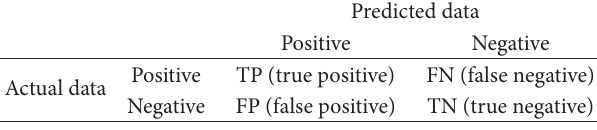
Table 4: Confusion matrix of evaluation indicators.